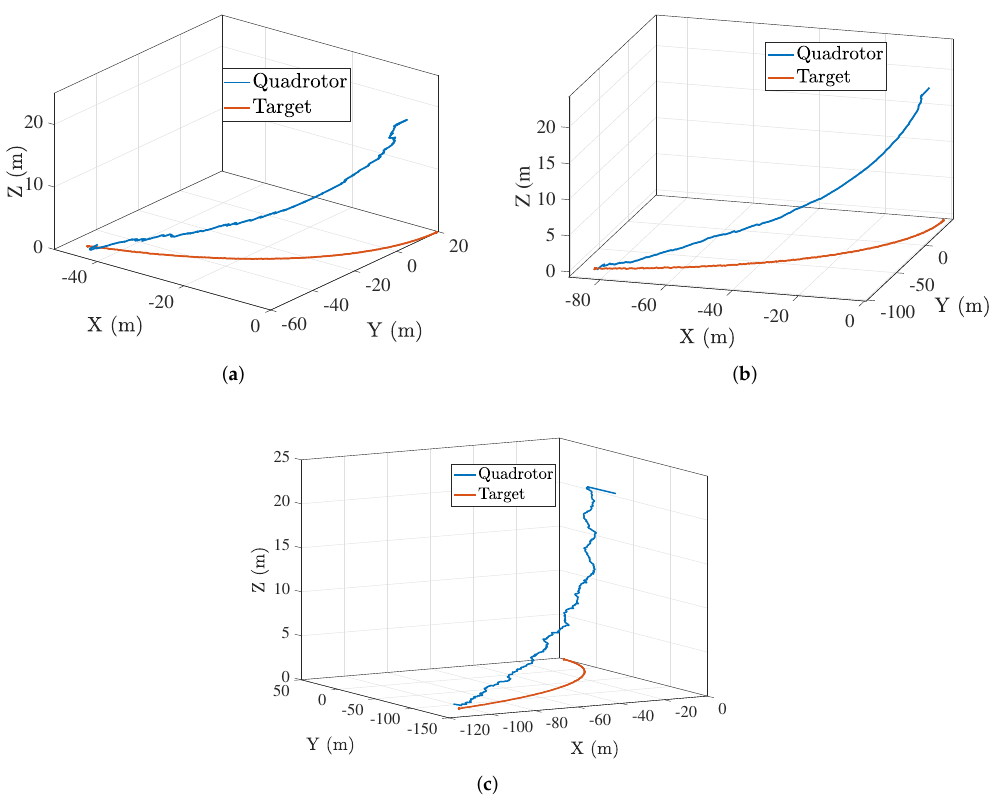
Figure 5. Landing trajectory followed by unmanned aerial vehicle (UAV) when ground vehicle moves in a near straight line trajectory at ( a ) V t = 1 m/s ( b ) V t = 2 m/s ( c ) V t = 3 m/s